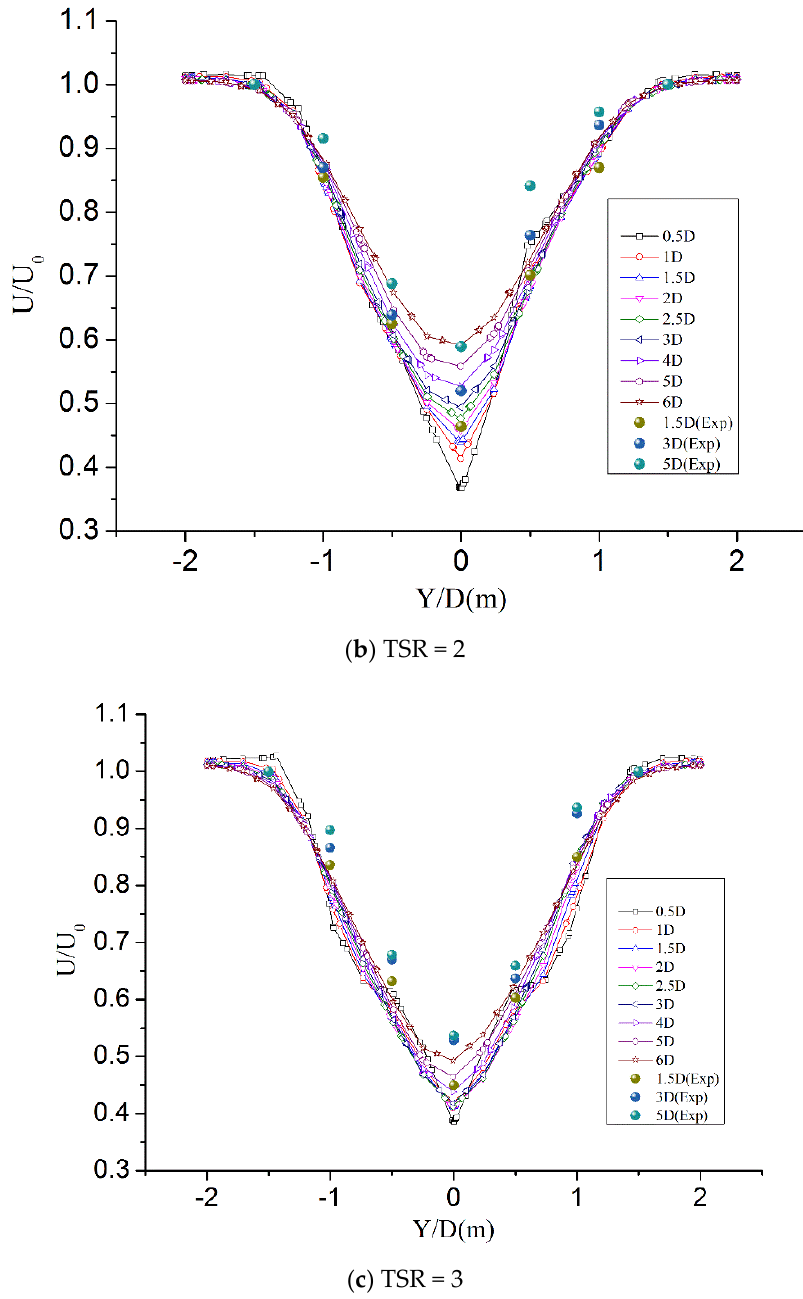
Figure 12. (a ) The velocity profile downstream in TSR=1 by CFD and experiment. ( b ) The velocity Figure 12. ( a ) The velocity profile downstream in TSR = 1 by CFD and experiment. ( b ) The velocity profile downstream in TSR=2 by CFD and experiment. ( c ) The velocity profile downstream in TSR=3 profile downstream in TSR = 2 by CFD and experiment. ( c ) The velocity profile downstream in by CFD and experiment.nt. TSR = 3 by CFD and